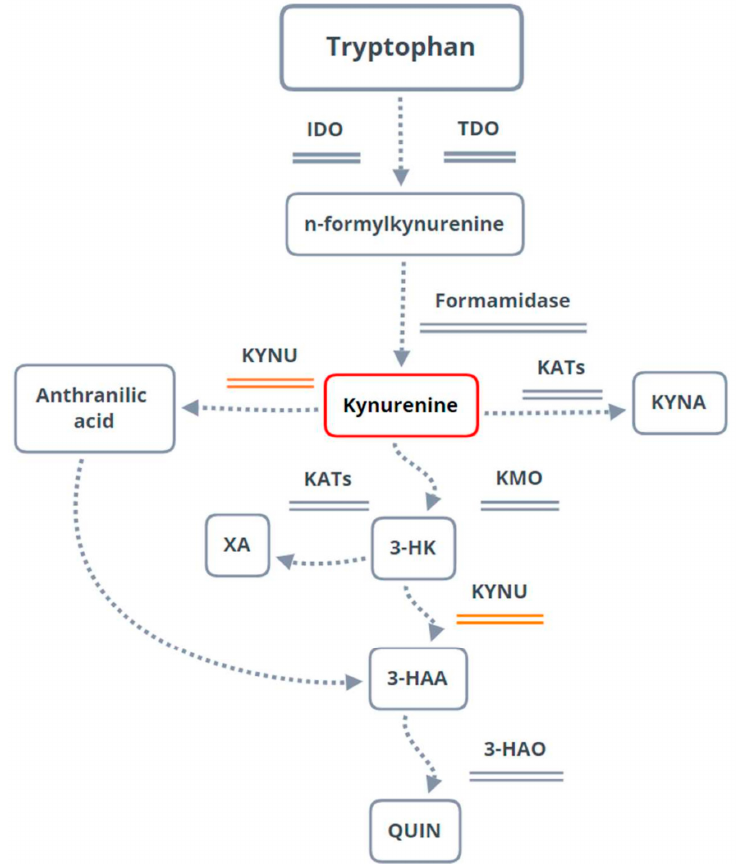
Figure 5. The tryptophan pathway, with emphasis on the kynurenine pathway (KP) and kynureninase (KYNU) participation. The KP is responsible for catabolizing 95% of the tryptophan available in the body [42,43]. In the brain, tryptophan is catabolized into formylkynurenine by the action of indoleamine 3-dioxygenase (IDO) and later in kynurenine (KYN) by formamidase. KYN can be processed by three different enzymes, leading to other routes. If processed by kynureninase (KYNU), the formation of anthranilic acid will occur, which can later serve as a precursor for the formation of 3-hydroxyanthranilic acid (3-HAA). If KYN is catabolized by kynurenine aminotransferases (KATs), kynurenic acid (KYNA) will form. Finally, KYN can be processed by kynurenine 3-monooxygenase (KMO), resulting in 3-hydroxykynurenine (3-HK), which can be metabolized by KYNU, giving